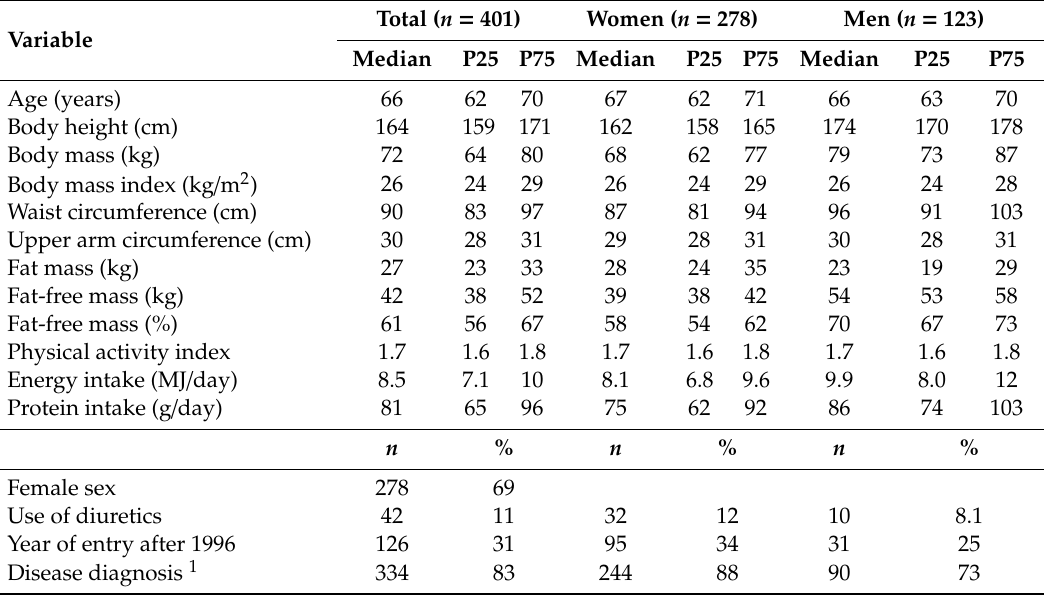
Table 1. Characteristics of the GISELA subjects at baseline.